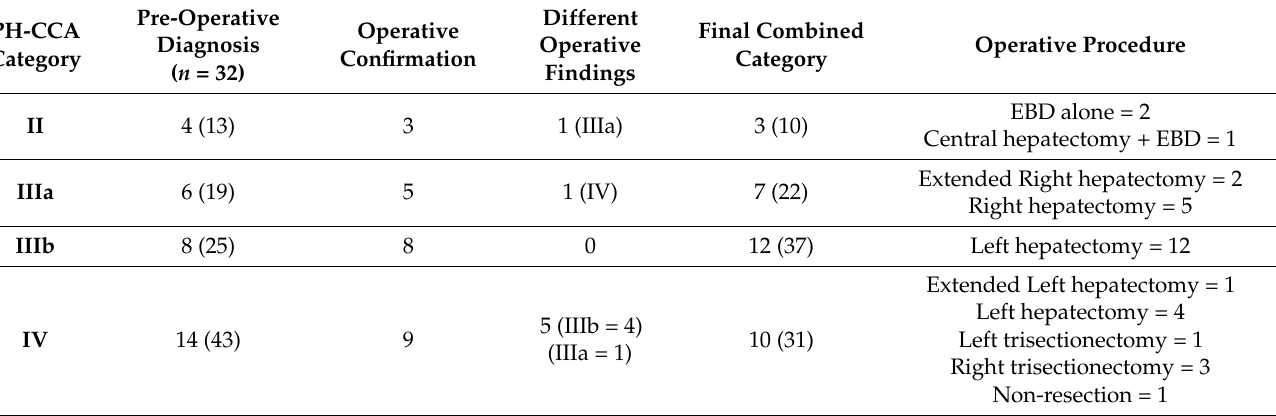
Table 4. Pre-operative radiological diagnosis, intra-operative correlation and choice of